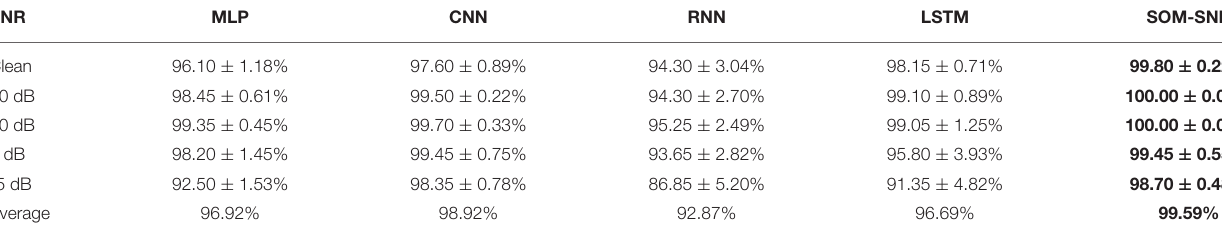
TABLE 4 | Average classification accuracy of different models with multi-condition training.